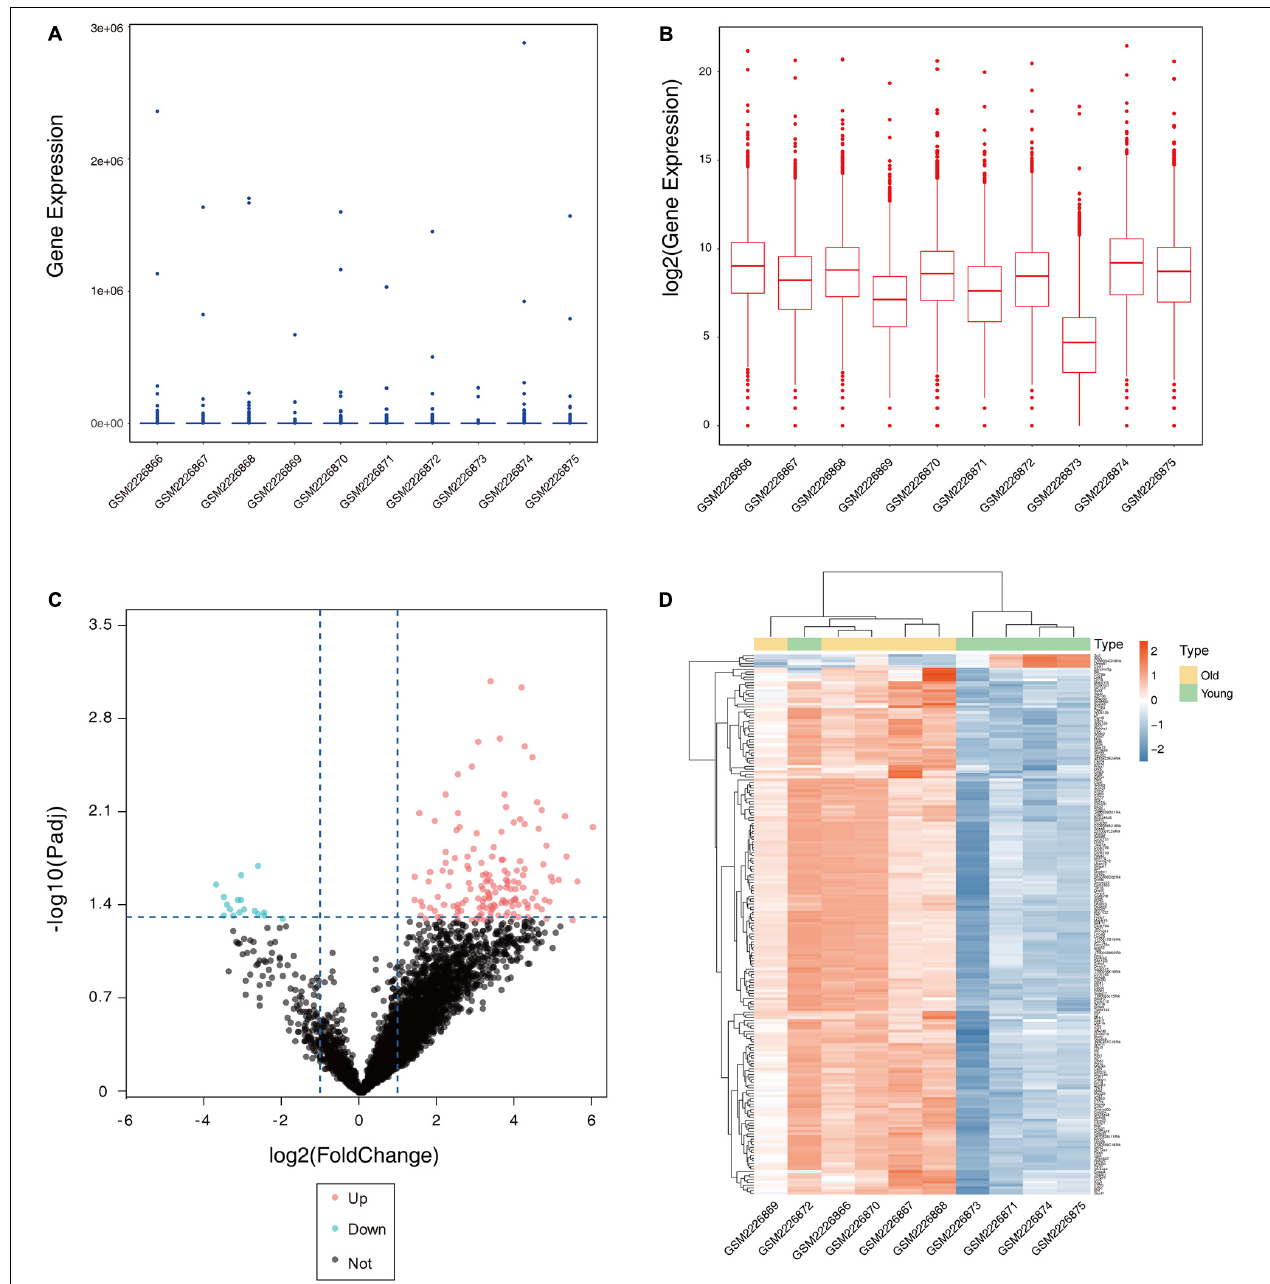
FIGURE 1 | Boxplot, volcano plot, and heatmap of gene expression of the dataset GSE84078. Box and whisker plot of GSE84078 before normalization (A) and after normalization (B) . Volcano plot of old and young groups (C) . Heatmap for selected differentially expressed genes between old and young ovary groups. A total of 931 DEGs are screened in normal old and young mice ovaries. A process of gradual color change from red to blue indicates expression values changing from high to low (D) . DEGs, differentially expressed genes; FC, fold